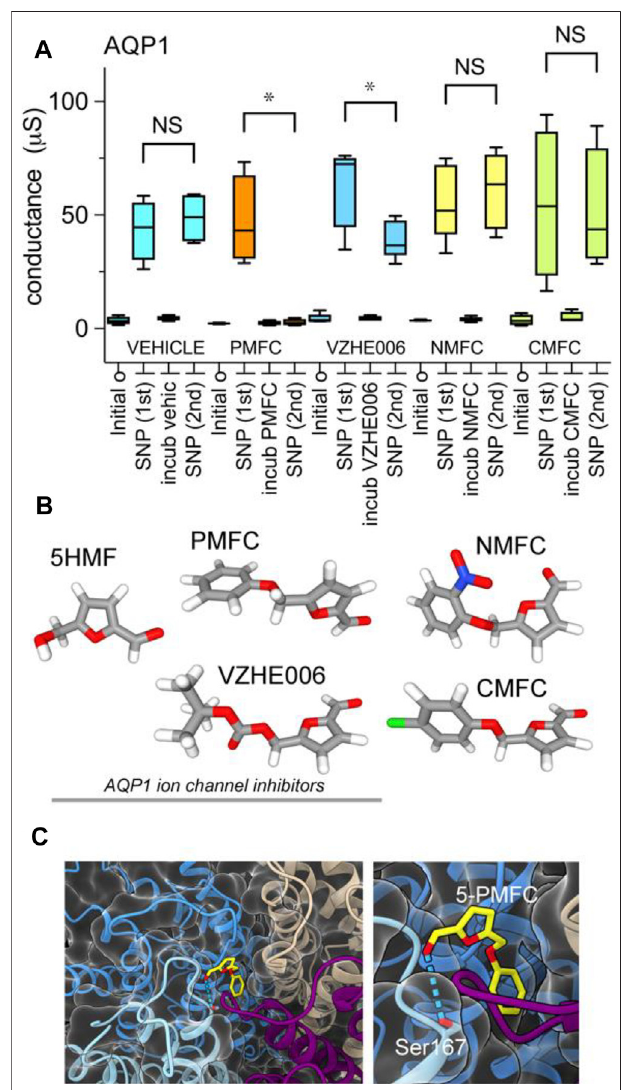
FIGURE 3 | Compiled data showing the effects of furan derivatives on the amplitude of the cGMP-dependent AQP1 ion conductance activated by SNP. (A) Compiled box plot data showing statistically signi fi cant inhibition of the AQP1 ion conductance by 5-PMFC or VZHE006, but not vehicle, 5- NMFC or 5-CMFC. n values were four each for all but 5-NMFC which was 5. Statistical signi fi cance was determine by paired Students t test; * p < 0.05; NS not signi fi cant. (B) Space fi lling structures of the compounds tested; the three on the left act as AQP1 inhibitors. (C) In silico docking model illustrating the predicted site for the most favorable interaction of 5-PMFC with AQP1, located near the central pore vestibule of the tetrameric channel in the loop D gating domain, which is seen as a curved purple strand connecting transmembrane helices (left panel). Higher magni fi cation view of the predicted hydrogen bond interaction between 5-PMFC and Ser167 (right